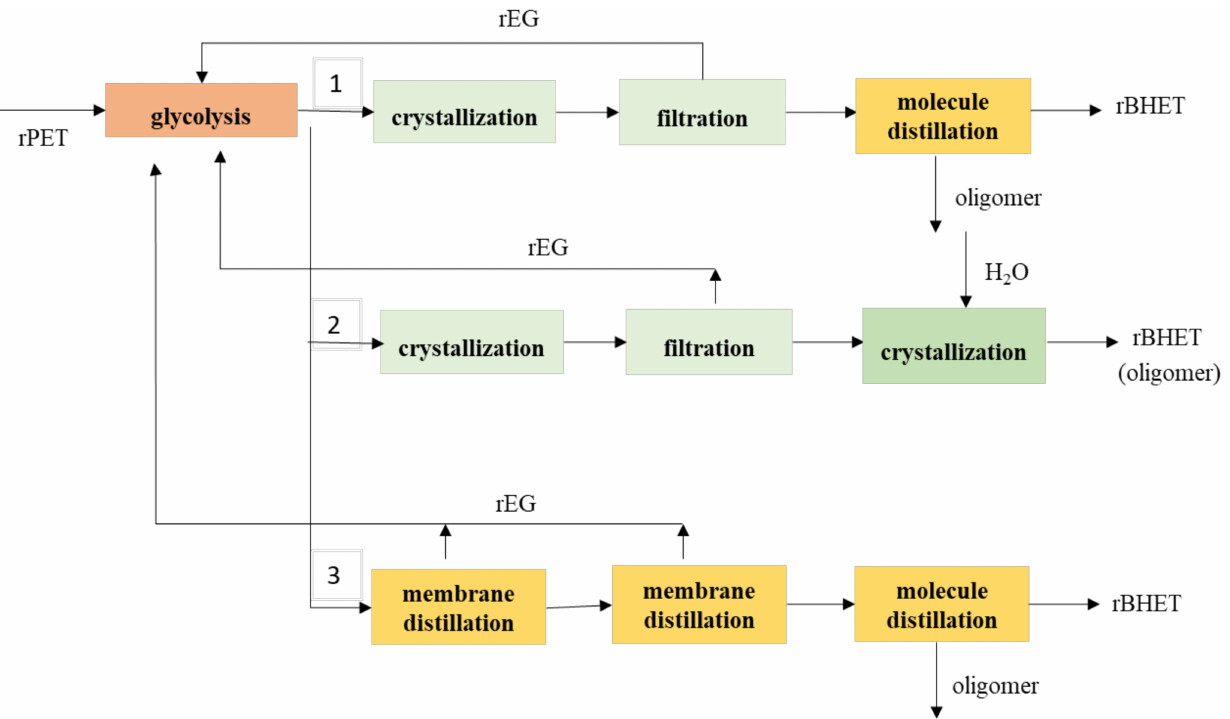
Figure 6. The 3 possible process path of PET glycolysis with different separation